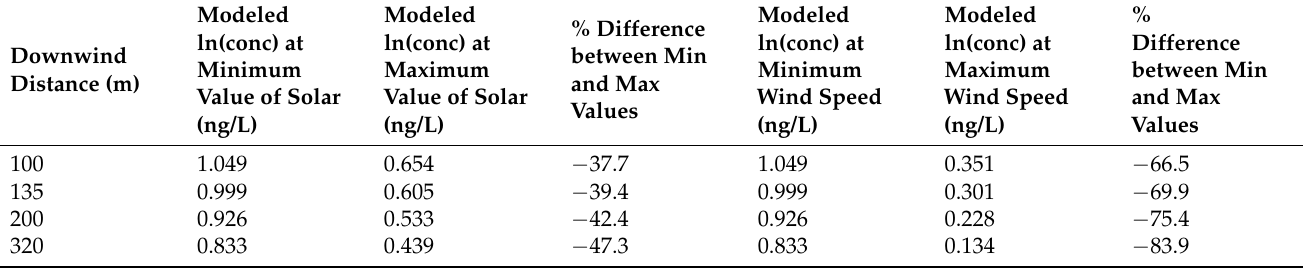
Table 2. Modeled ln (concentration) at minimum and maximum values of variables wind speed and solar radiation for Weather Method 1. Value of the other variable was held to minimum value to illustrate the effect of changes in the variable of interest.